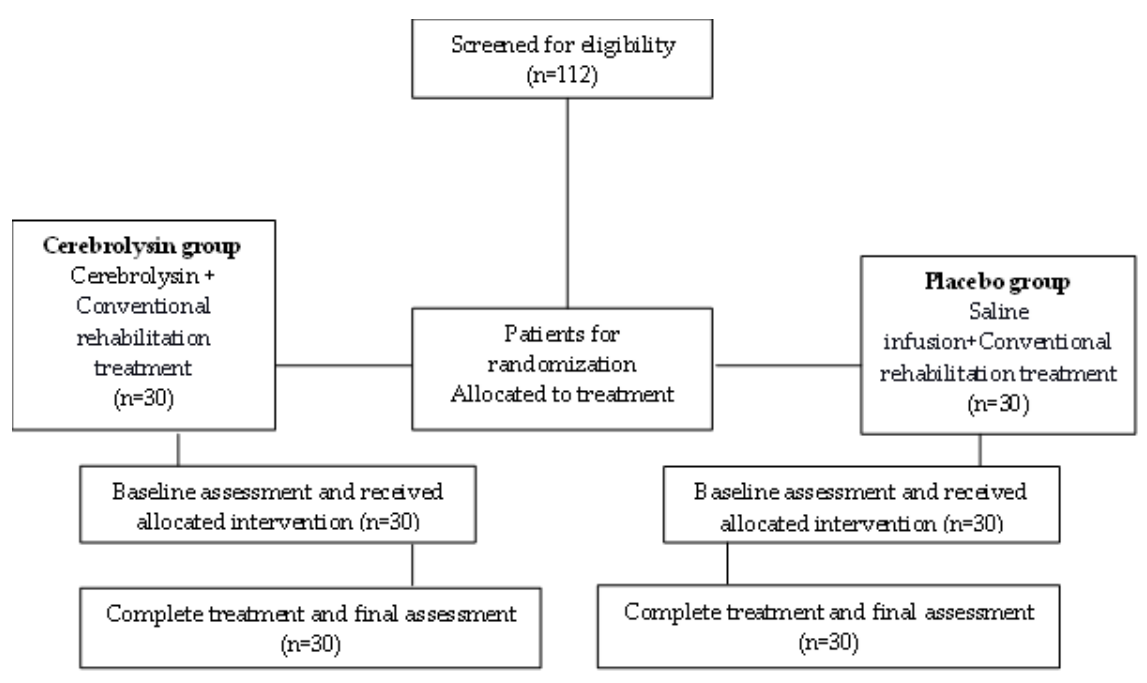
Figure 1. Flow diagram of patient recruitment.